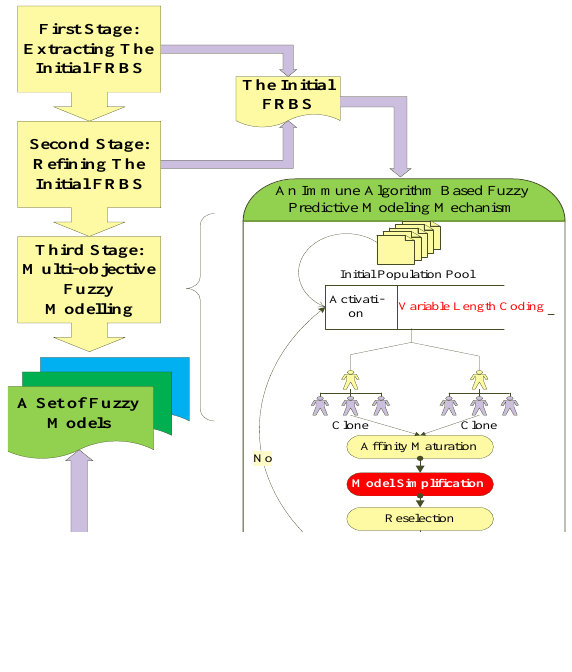
Fig. 2. The proposed IMOFM